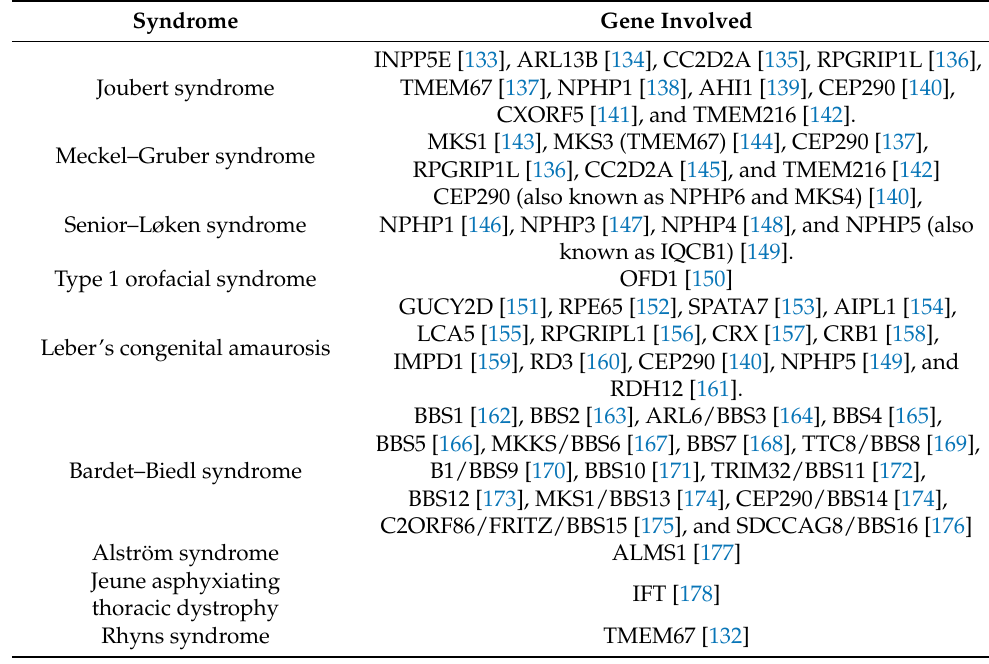
Table 2. Genes involved in